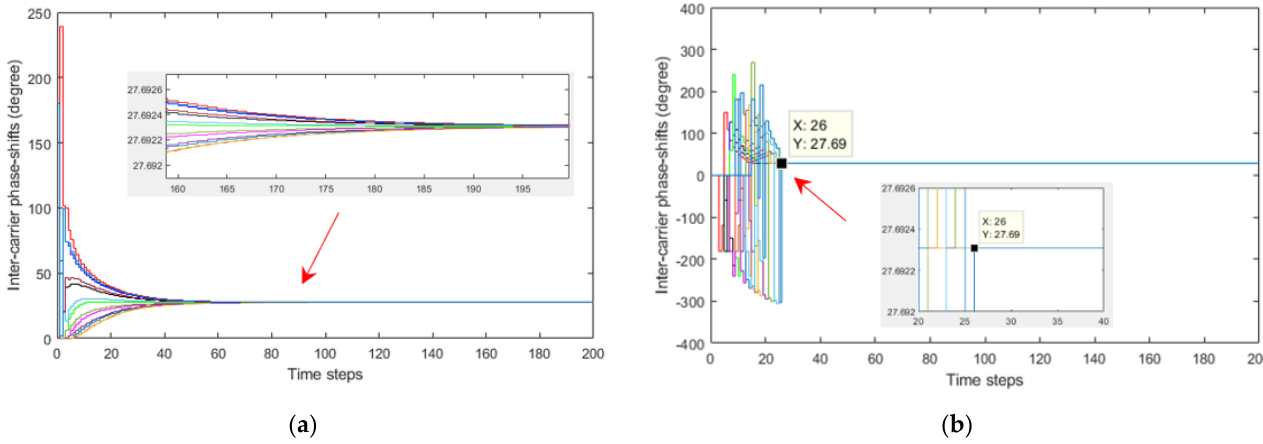
Figure 27. The inter-carrier phase-shifts of a converter with 13-carriers, startup with ( a ) conventional modified updating rule; ( b ) proposed DSA-PSC.